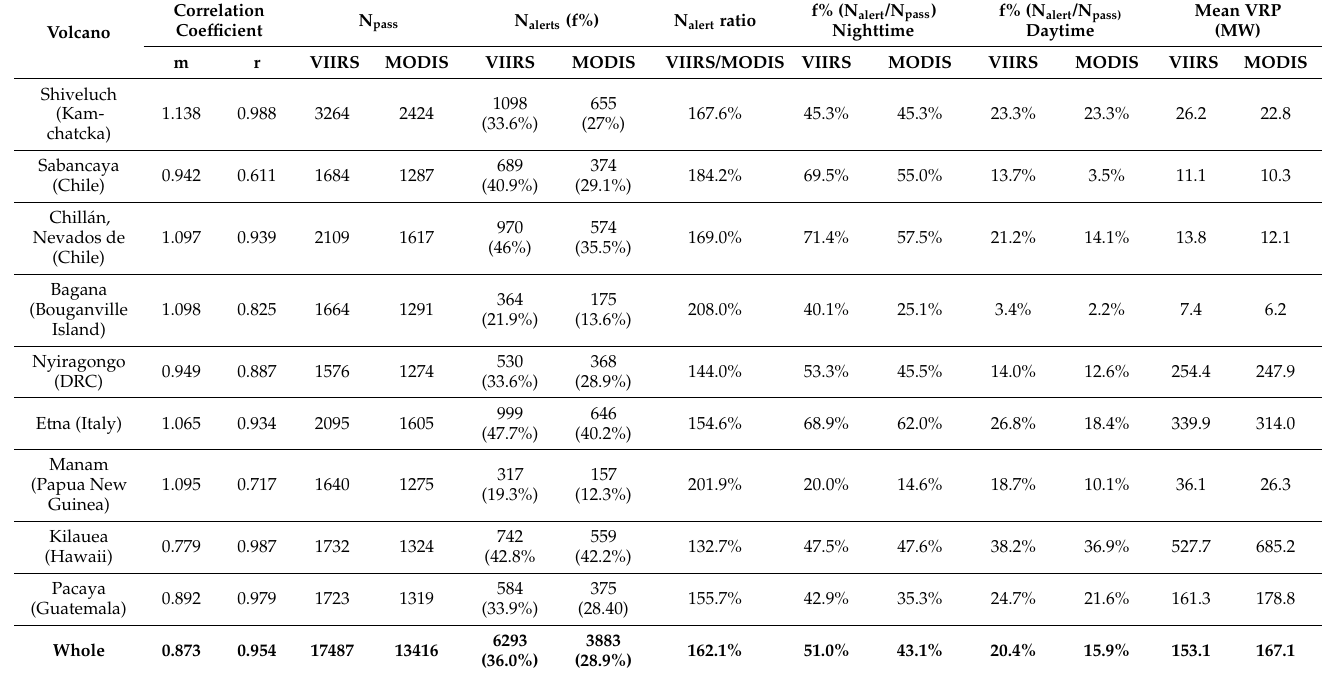
Table 4. Comparison between the 2021 datasets of VIIRS and MODIS for selected volcanoes. The summary includes the correlation coefficient shown in Figure 11, the number of overpasses (N pass ), the number (N alerts ), the frequency (f% = N alert /N pass ) of alerts (subdivided into nighttime and daytime data), the ratio between VIIRS and MODIS detections, and the mean VRP obtained by averaging the weekly dataset showed in Figure 11 and Supplementary